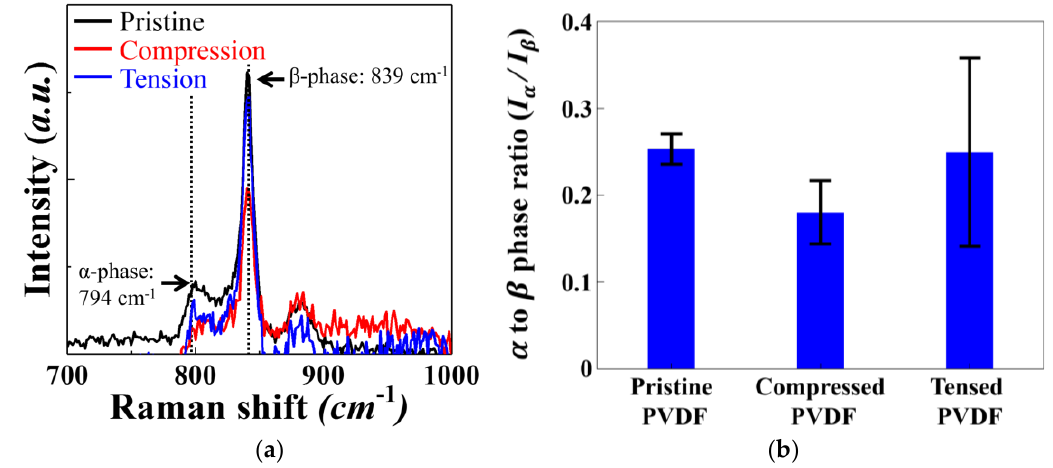
Figure 4. ( a ) The Raman shift observed for PVDF at pristine and after applying 10 7 tensile and compressive stress. ( b ) The average intensity ratio ( I α /I β ) with the standard deviation plotted as the error bars.